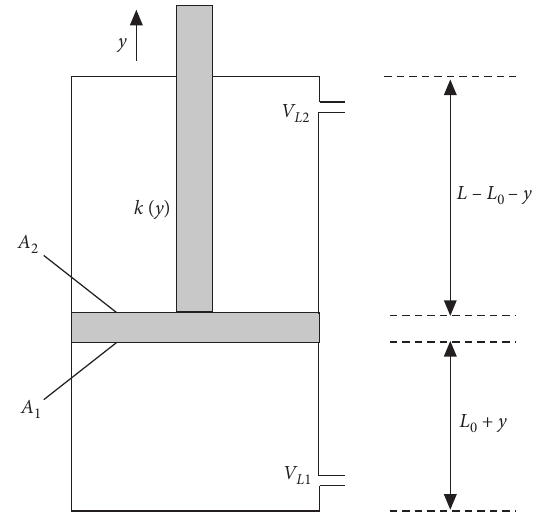
Figure 2: Structure diagram of a double-acting single-piston servo hydraulic cylinder.